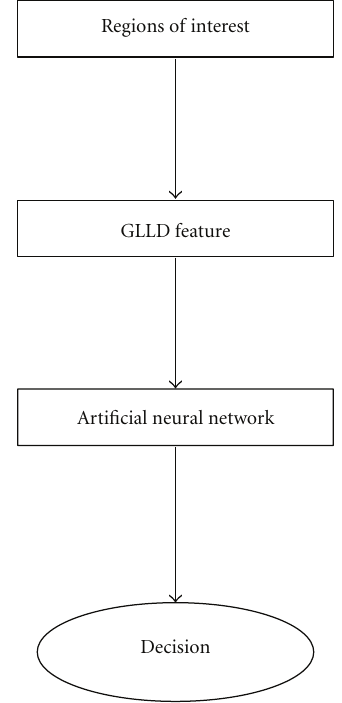
Figure 9: Implementation of the proposed